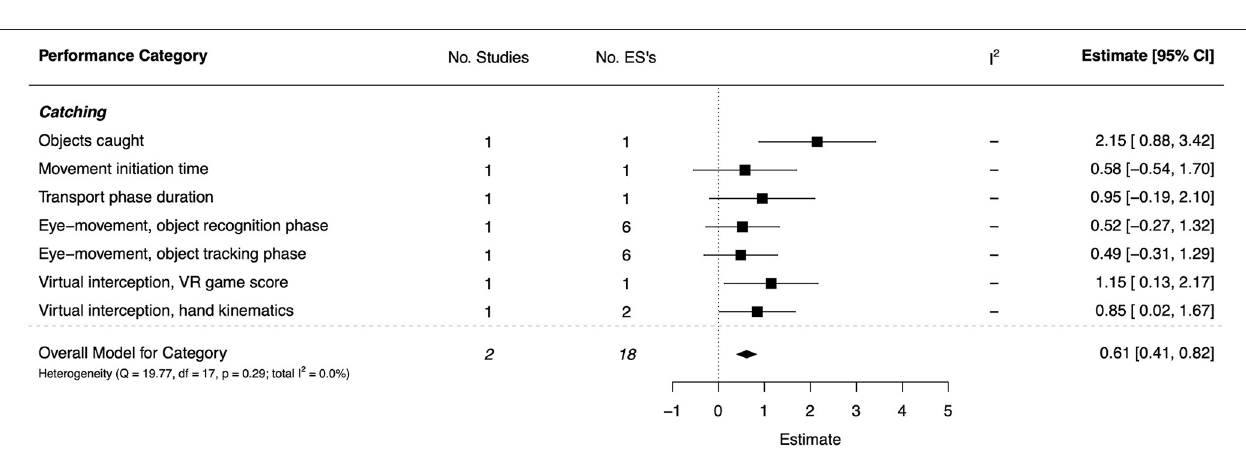
FIGURE 10 | Forest plot showing the meta-analysis results for the catching performance category. VR, Virtual